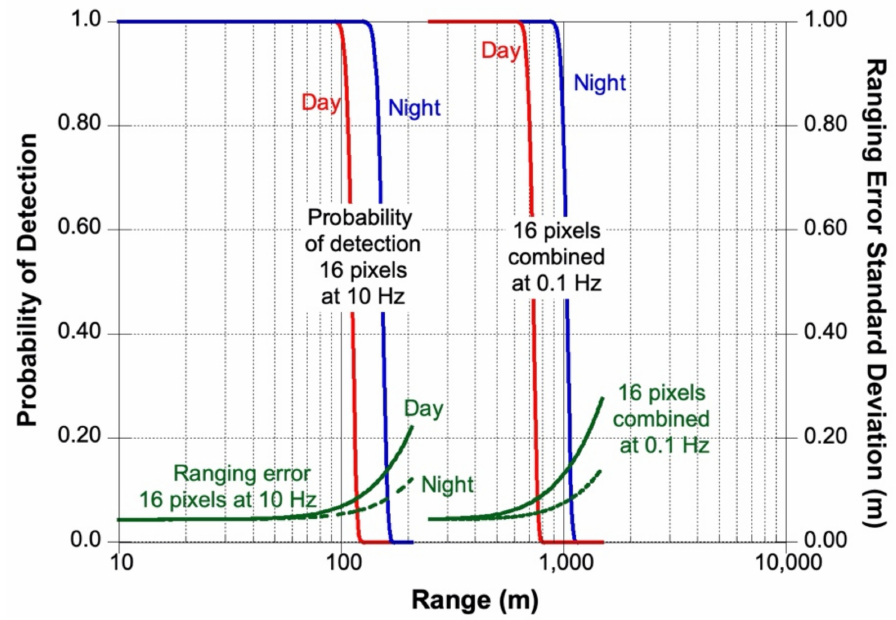
Figure 3. Calculated SALi ranging performance based on the measurement model above and instrument parameters given in Table